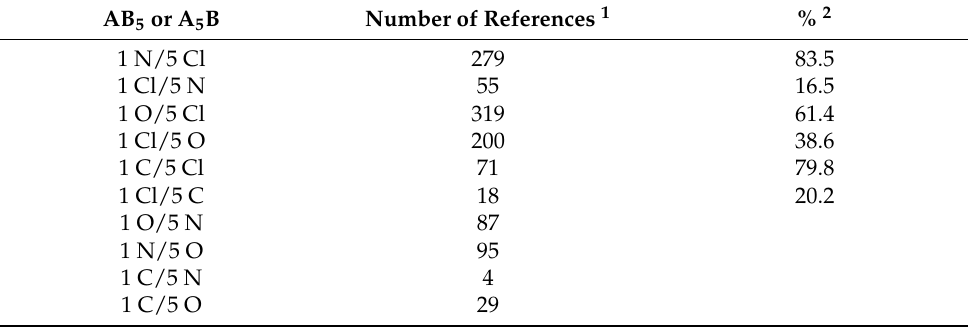
Table 1. Number of references (and %) concerning AB 5 derivatives of cyclotriphosphazene. AB 5 or A 5